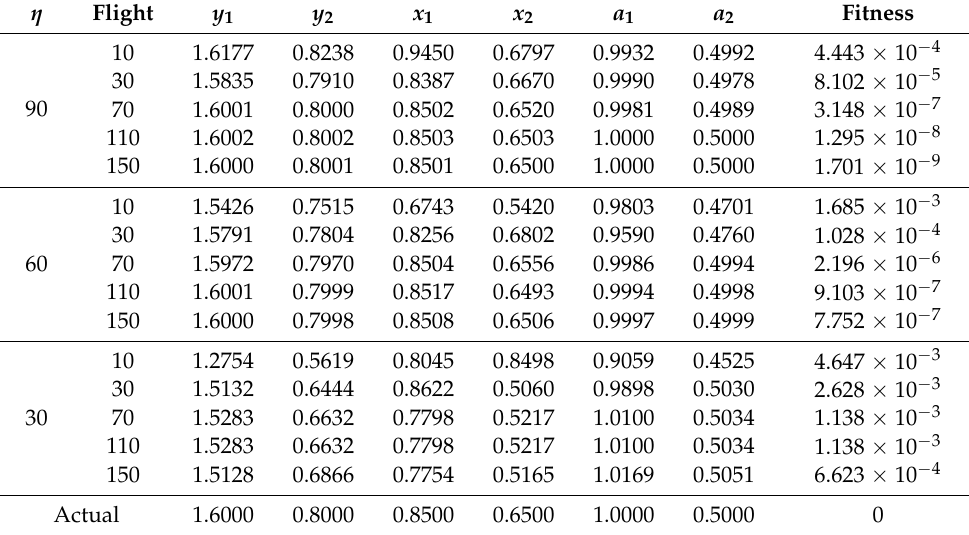
Table 2. Parameter estimates with the level of estimation accuracy for ε = 0.5.